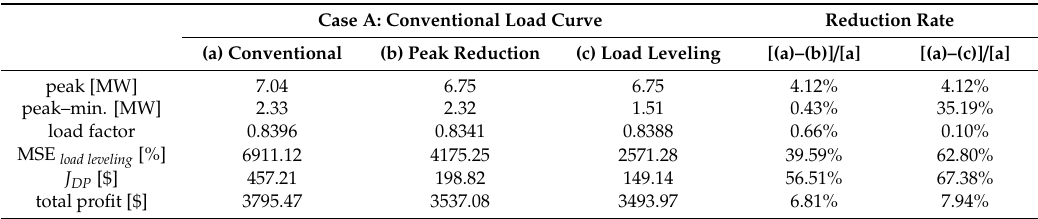
Table 4. Comparison of the data obtained applying the proposed method and conventional method to the conventional load curve.